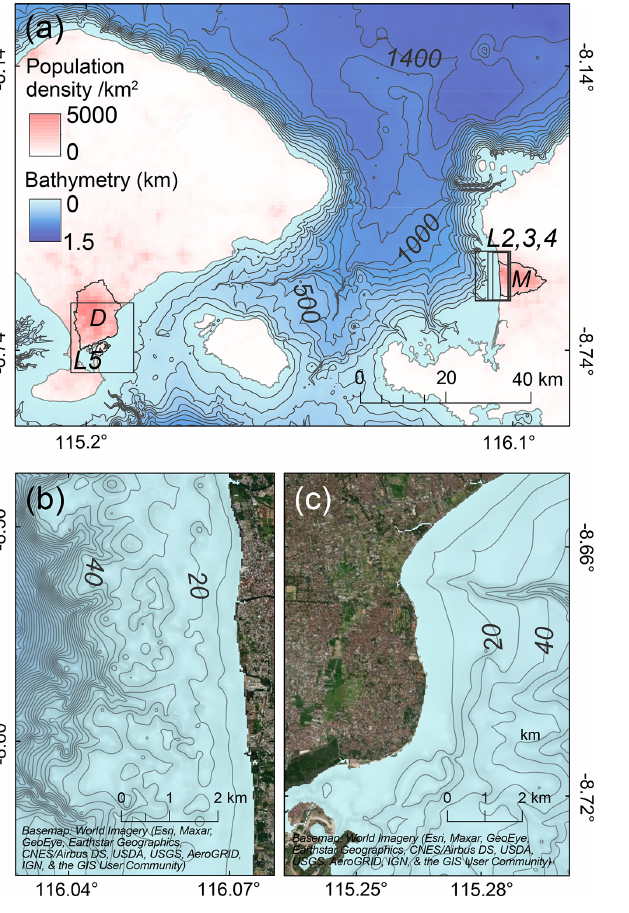
Figure 6. The generated bathymetry in the Lombok Strait. (a) The bathymetry has a north–south-trending ridge along a narrow path between Bali and Lombok with its base at 1.4km water depth, which is the deepest water depth in this region. The extent of (a) matches the extent of grid layer L1 used in the tsunami modeling. The finer grid layers L2–L4 and L5 are focused on the populated cities of Mataram and Denpasar, respectively. M denotes Mataram; D denotes Denpasar. Grid resolutions: L1 is 150m; L2 and L5 are 30m; L3 is 6m; L4 is 1.5m. The population density is from World- Pop (Bondarenko et al., 2020). (b) The linear coast of Mataram faces a rugged but gently dipping seafloor that suddenly steepens ∼ 3–4km from the coast. (c) Denpasar has a more complex coast- line and a smoother seafloor. Basemaps – World